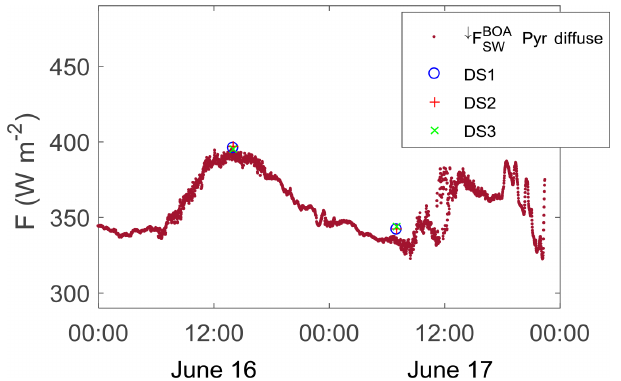
Figure 10. Time series of the ↓ F LW at the BOA during the period 16–17 June. Surface measurements of diffuse (red) radiation from the ground-based pyranometer at the Granada station are included. GAME output data for different inputs are represented by the blue circles (DS1), red (DS2), and green (DS3) crosses. Figure 11. Direct ARE profiles in the LW spectral range simu- lated using DS1 (blue line), DS2 (red line), and DS3 (green line) as aerosol input data in GAME for 16 June (a) and 17 June (b) .